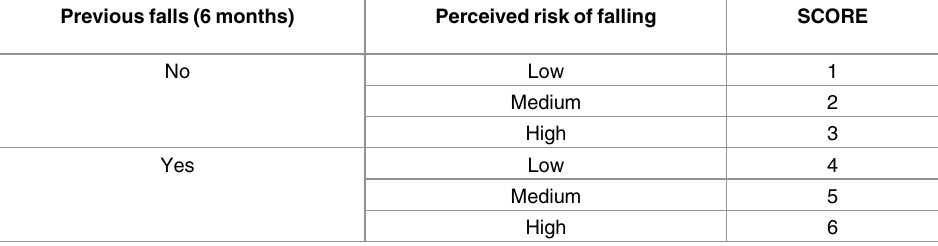
Table 1. Scoring of a questionnaire built with two questions regarding history of falls and perceived fall